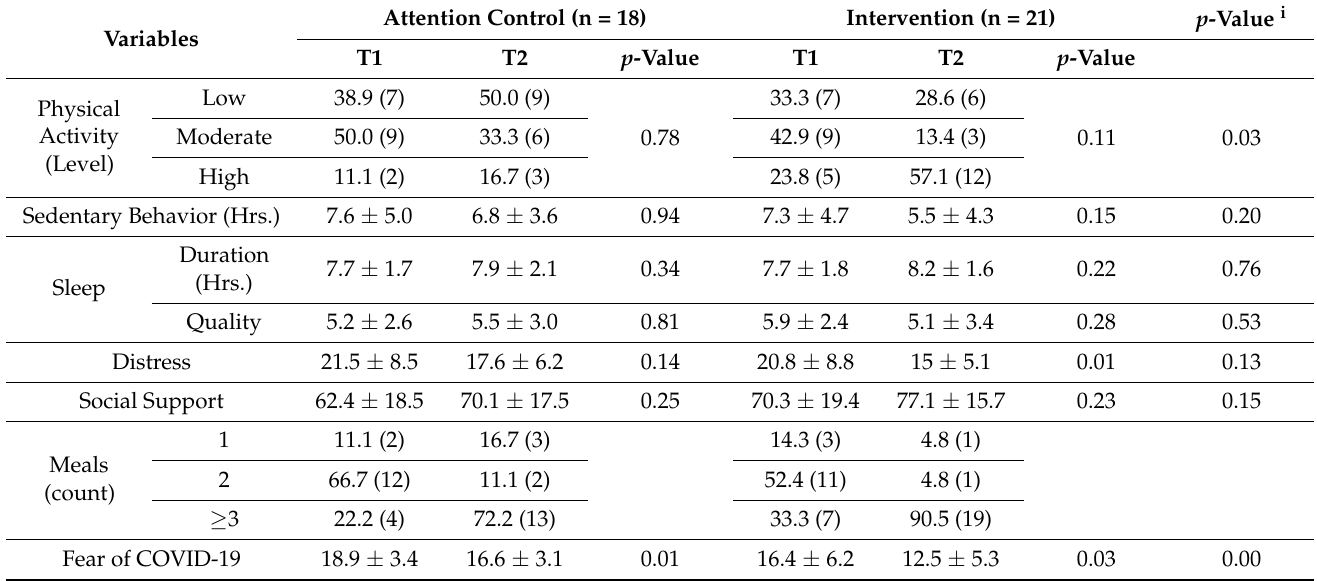
Table 3. Lifestyle behavior variables and related outcomes. Data compared using student’s t -test, Mann–Whitney test or chi-square test. Data reported as mean ± SD or frequency (n). T1 is